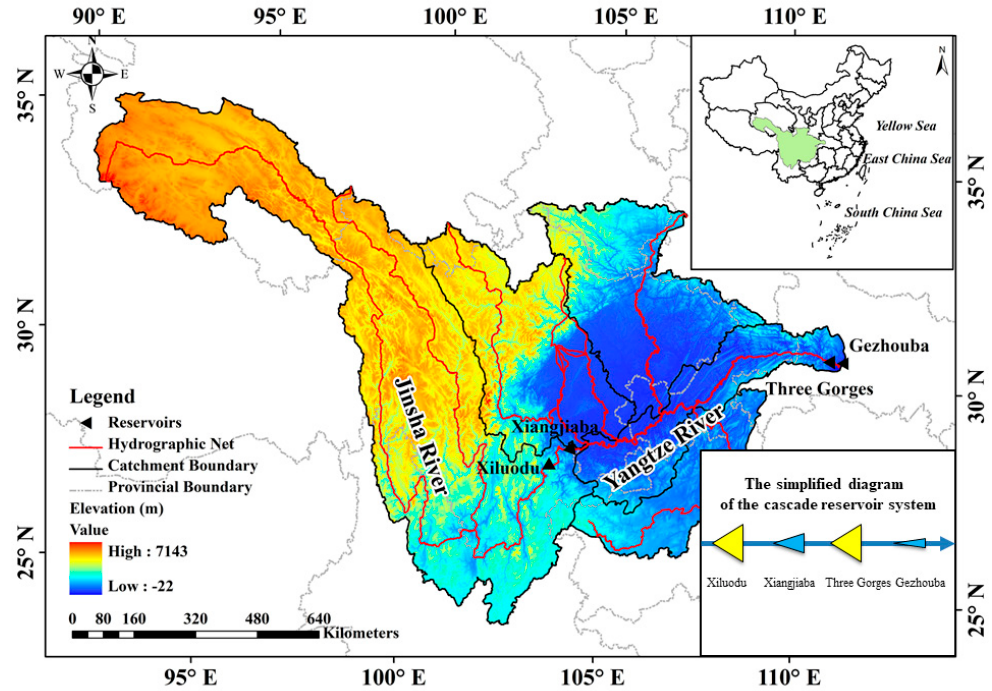
Figure 1. Location sketch map of the Three Gorges cascade reservoir system.